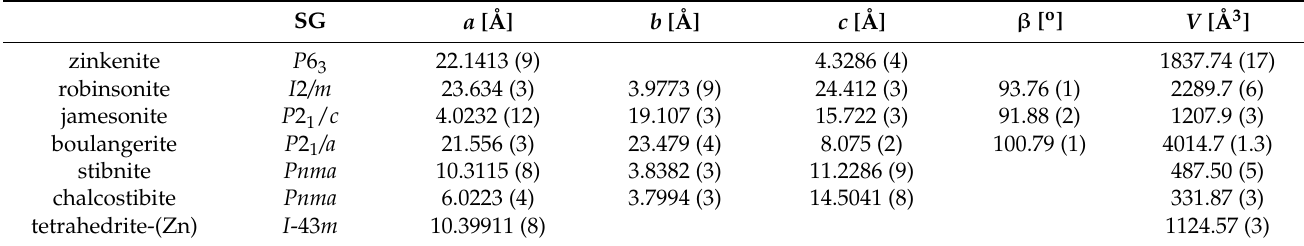
Table 1. Unit-cell parameters for selected sulphosalts from Kľačianka refined from PXRD.